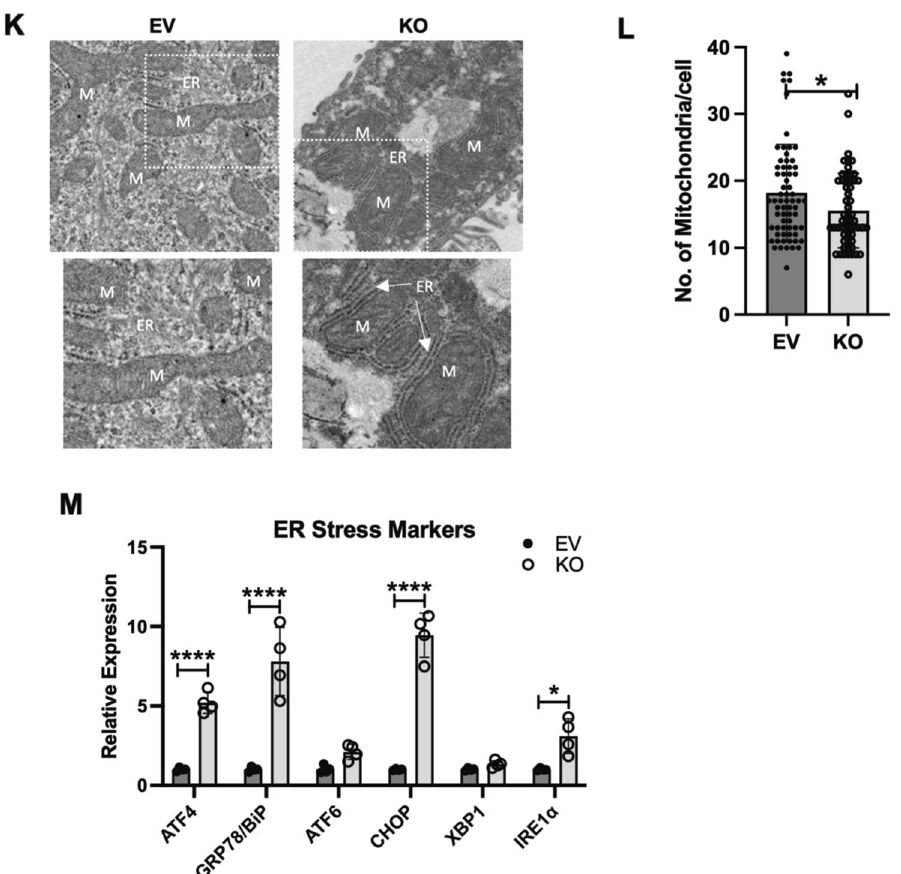
Fig. 5 HKDC1 is essential for mitochondrial function in LC. Cell fractionation experiment showing cytosolic, membrane and nuclear fractions in A EV and KO HepG2 cells and B Hep3B2 cells. C EV and KO HepG2 cells were used in co-immunoprecipitation experiments where IP was done with anti-VDAC antibody and then immunoblotting (IB) was done with HKDC1 antibody. D Liver sections from DEN treated HKDC1 f/f and HKDC1-LKO mice were used to show HKDC1-VDAC interaction by immunohistochemical staining of HKDC1 and VDAC (images are representative of n = 3 per group). E Seahorse metabolic analysis (OCR) of EV and HKDC1-KO cells and siRNA-mediated HKDC1 knockdown (siHKDC1) in Hep3B2 and SNU475 cells (center and right panels). F Activity assay for mitochondrial complex I (left panel), SDH (center panel) and complex III (right panel) of EV and HKDC1-KO cells. G Intracellular ATP levels relative to EV (fold-change) ( n = 3). H Mitochondrial Ca 2 + levels were assessed by Rhod-2AM fl uorescence using fl ow cytometry of EV/HKDC1-KO cells (left panel) and Hep3B2 cells treated with siRNA against HKDC1 for 24 h (right panel). 50,000 cells were assessed for each sample, and data was plotted on bar graphs with statistics ( n = 3) for each cell line. I Mitochondrial membrane potential was measured by TMRE fl uorescence. J Intracellular ROS levels are shown. K HepG2 expressing empty vector (EV) or HKDC1 knockout (KO) cells were processed for TEM. In all, 20 – 25 images were taken for each cell at different magni fi cations. Images shown here were taken at 4000x. Inset (shown in white) was enlarged (below) to show mitochondria and ER (M = mitochondria, ER = endoplasmic reticulum). L Mitochondria were counted for each cell (20 – 27 cells per sample) by Image J software. All cell- line experiments were performed 2 – 3 independent times with 3 – 8 replicates per experiments. M qPCR analysis in EV and KO cells to assess mRNA levels of ER stress markers. Values are ±SD; * p < 0.05; ** p < 0.01; *** p < 0.001; **** p < 0.0001 by Student ’ s t -test (for B , E – G , I ) or 2 way ANOVA (for C , J